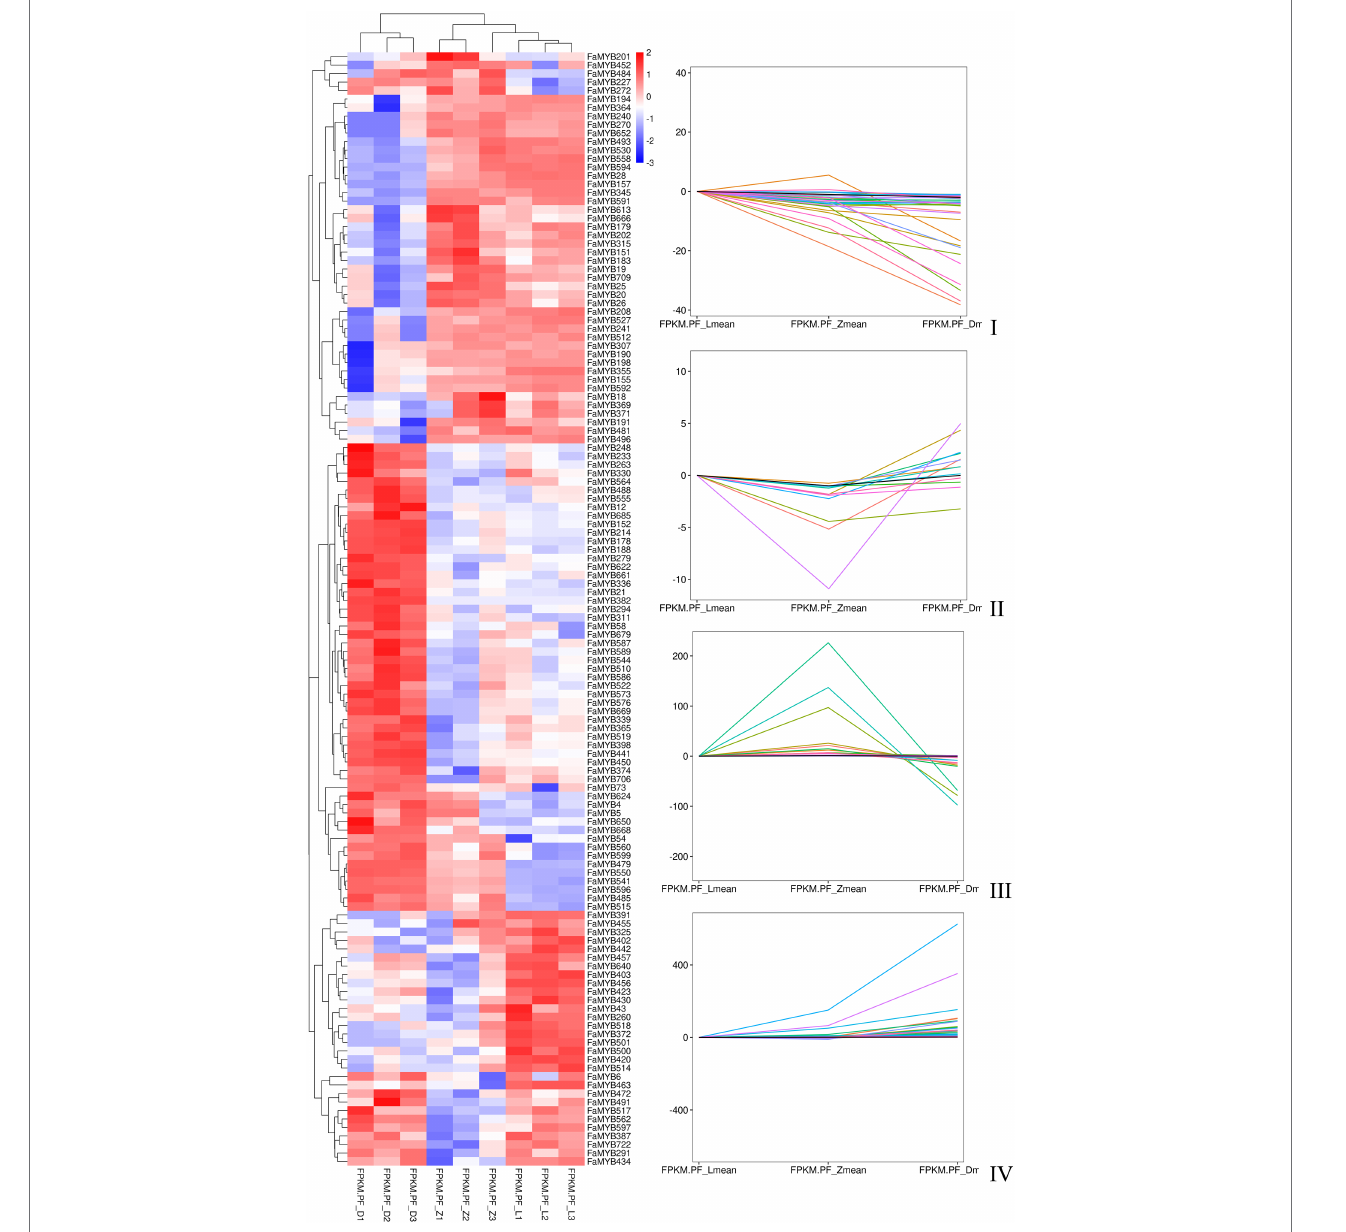
FIGURE 4 | The heat map and trend analysis of 131 differentially expressed MYB genes in three flower developmental stages of the pink-flowered strawberry using